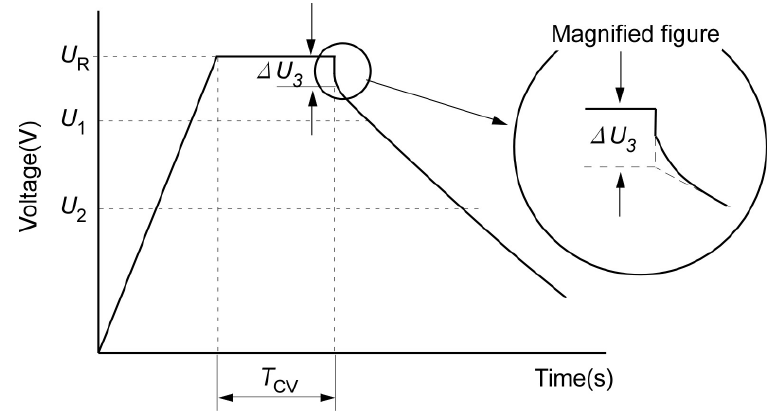
Figure 31. Internal resistance determination method for EDLCs according standard IEC 62576 [88].